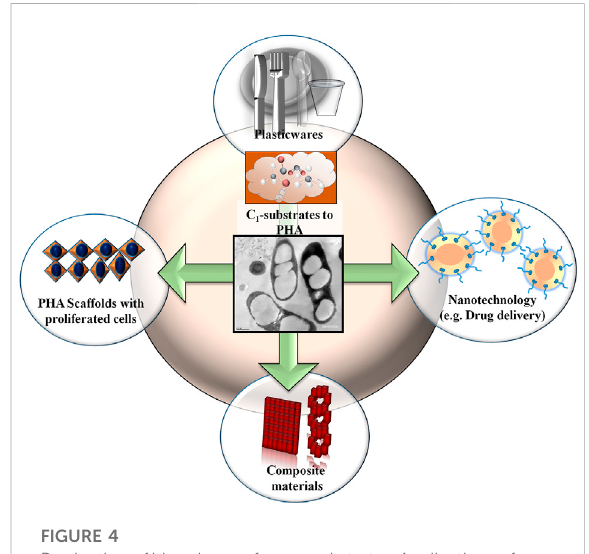
FIGURE 4 Production ofbiopolymersfromc,substrates.Applicationsof polyhydroxyalkanoate (PHA) in different fi